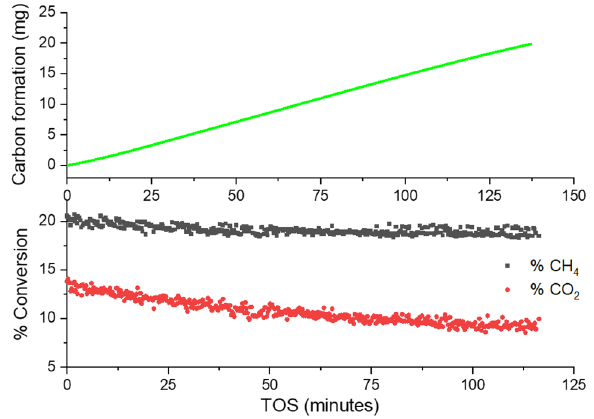
Figure 4. Carbon growth vs. TOS on 20 mg of commercial 20% Ni/γ-Al 2 O 3 catalyst and its corresponding conversion profiles of CH 4 and CO 2